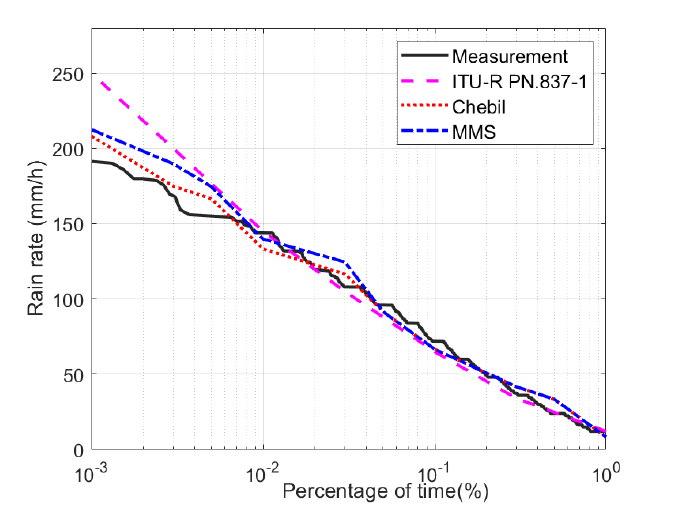
Figure 2. Cumulative distribution for maximum rain rate every minute for one